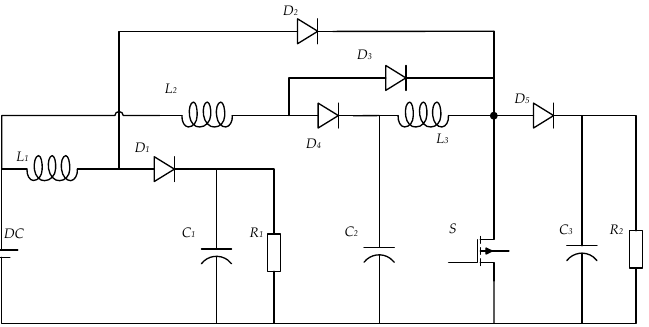
Figure 8. The final simplified synthesized circuit of the dual output converter.